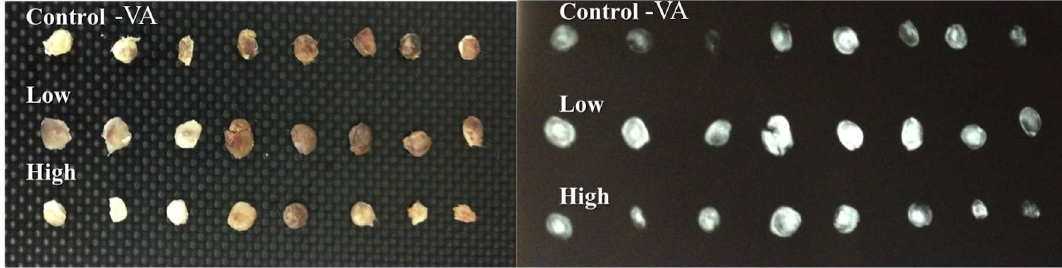
Fig 3. Macroscopic (left panel) and radiographic (right panel) aspects of ectopic bones among three groups (Control-VA: Control group of vibration acceleration groups, Low: Low-magnitude group, High: High-magnitude group).